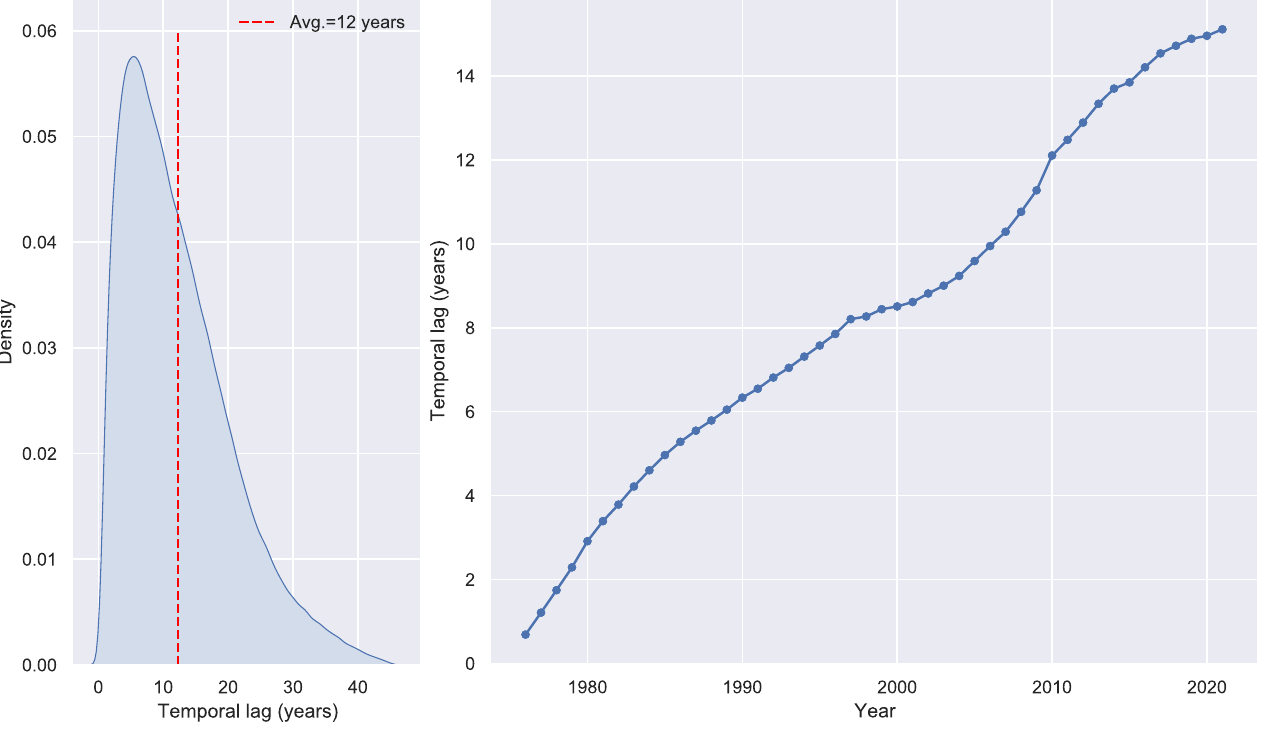
Fig 3. Temporal lag. Left : temporal lag distribution. Right : average temporal lag by year.